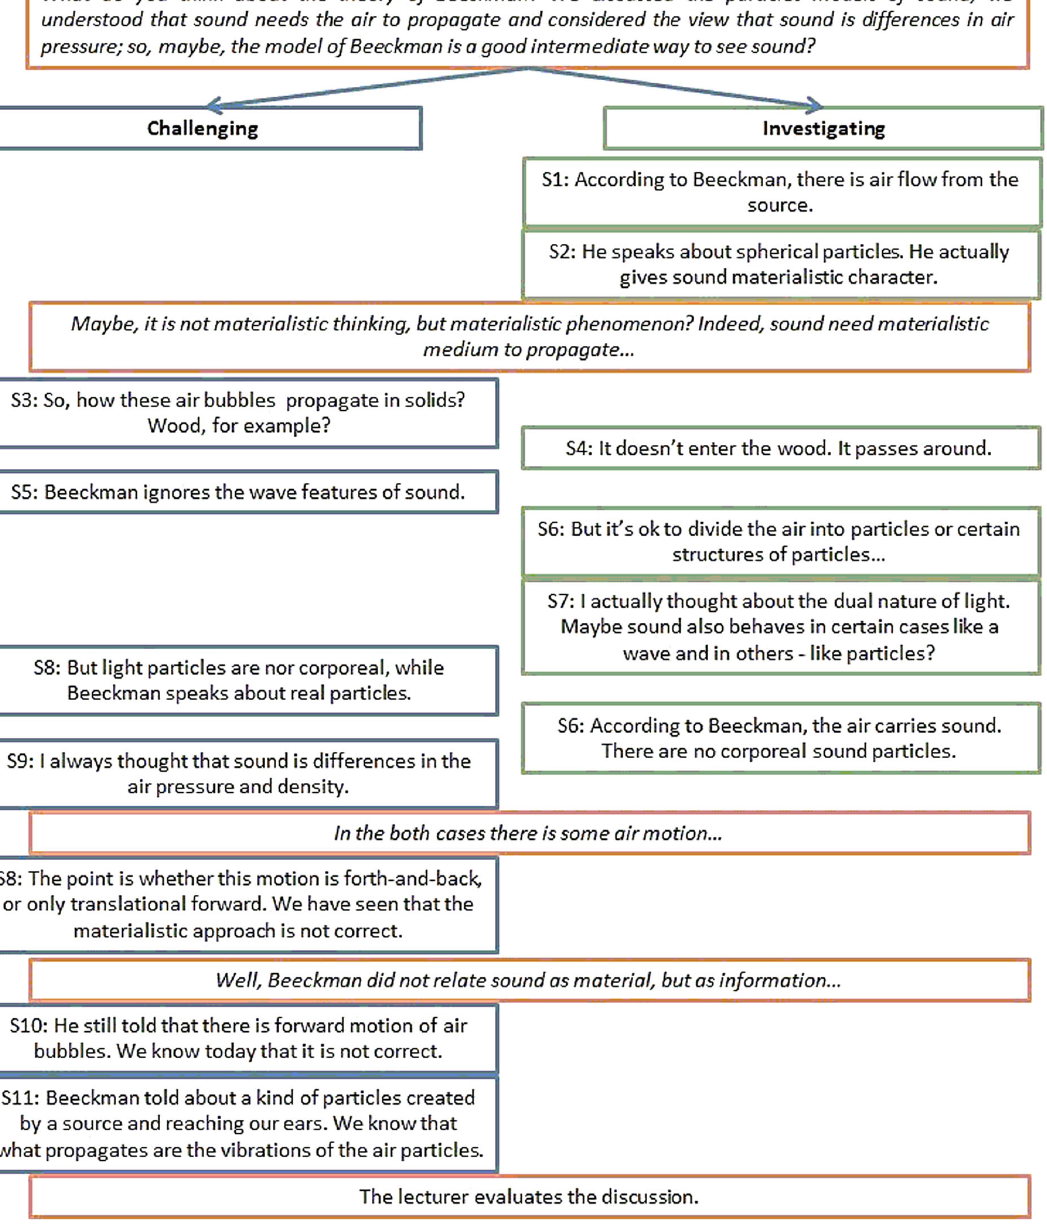
FIG. 3. WCDD about Beeckman ’ s air bubbles model. The lecturer ’ s interventions are shown in the orange boxes; ideas reflecting a wave model of sound are shown in the blue boxes; air bubbles are shown in the green boxes. The CFDM is characterized by the zigzag tower